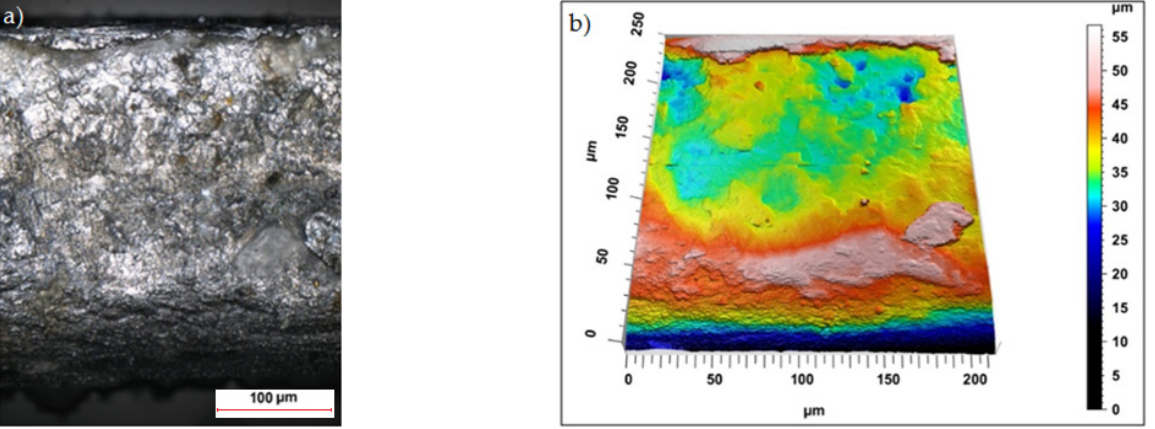
Figure 8. The view of the surface of the cut edge ( h c = 0.02 mm and v = 17.5 m/min): ( a ) surface photography, ( b ) surface topography (coated steel).